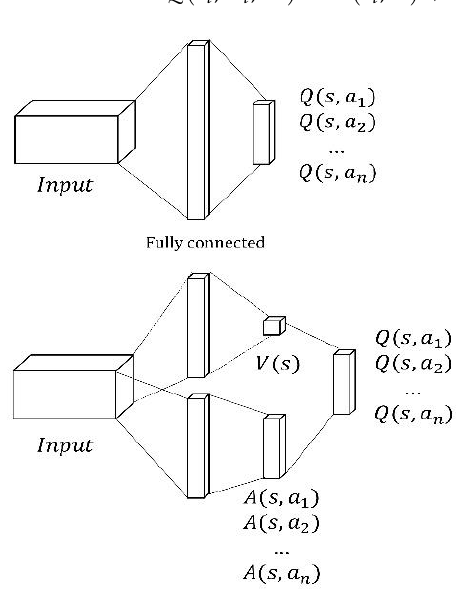
Figure 2. Deep Q-Network ( top ) and Dueling Deep Q-Network ( bottom ).